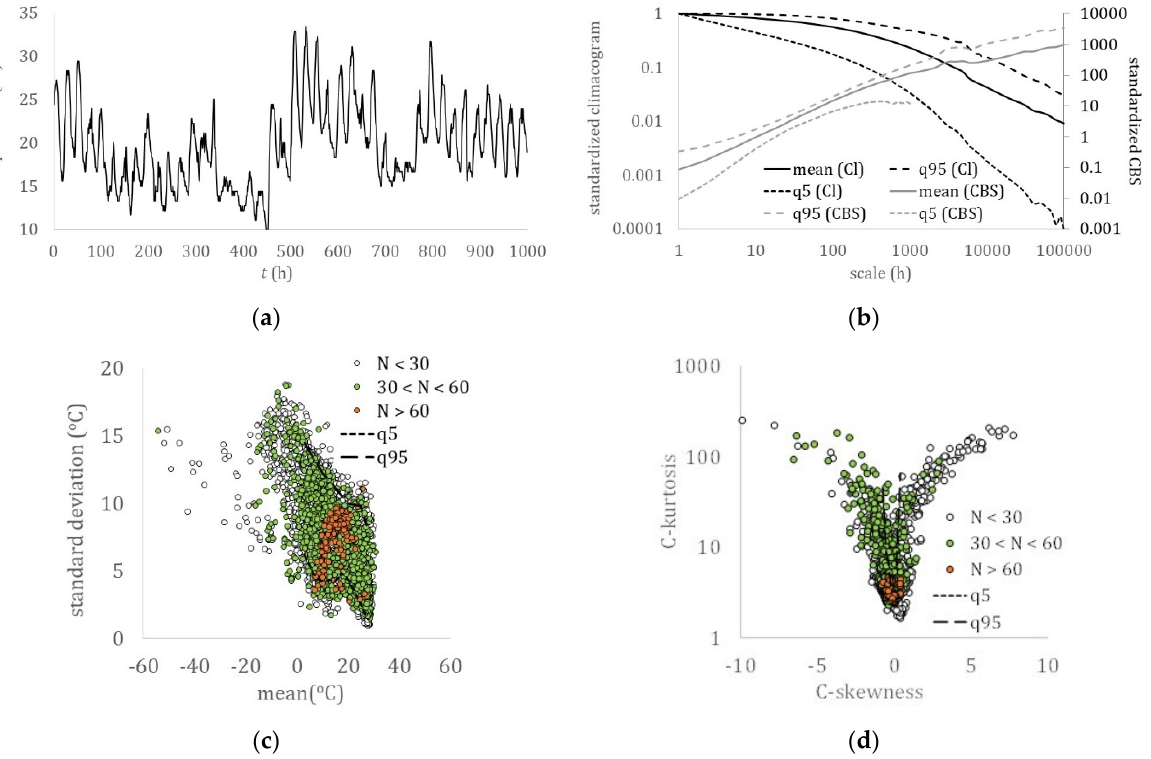
Figure 2. Near-surface air temperature: ( a ) hourly sample (Boston, USA); ( b ) climacogram and climacospectrum (mean, and 5% and 95% quantiles); ( c ) mean vs. standard deviation; ( d ) C-skewness vs. C-kurtosis.